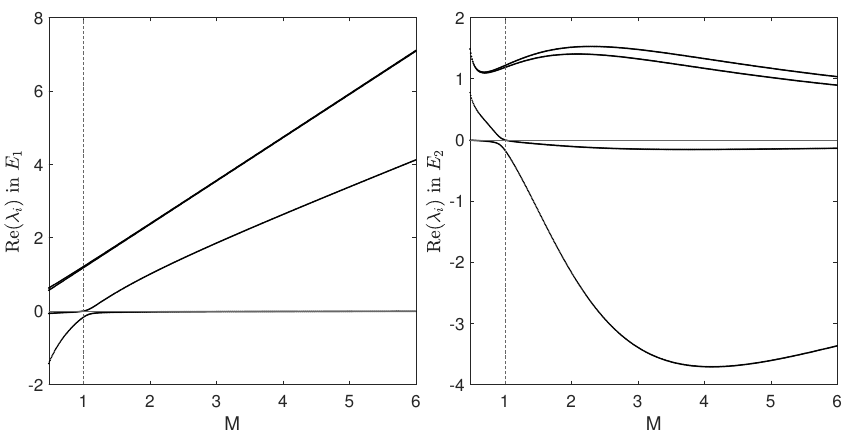
Figure 3. Eigenvalues of the Jacobian J | E of degrees of freedom: δ = 2, θ = 0.05, Pr = 0.761 which corresponds to ν = − 0.33.